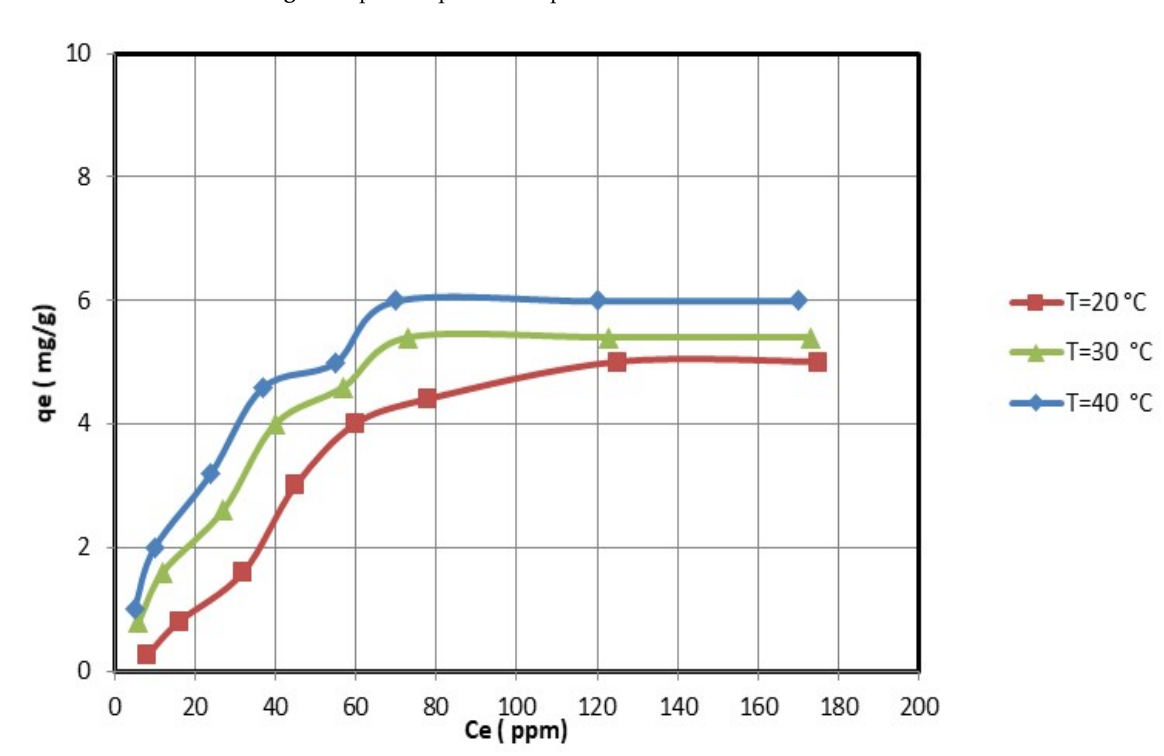
Figure 8. Adsorption of Ni ions on nanocellulose at di ff erent temperature levels.